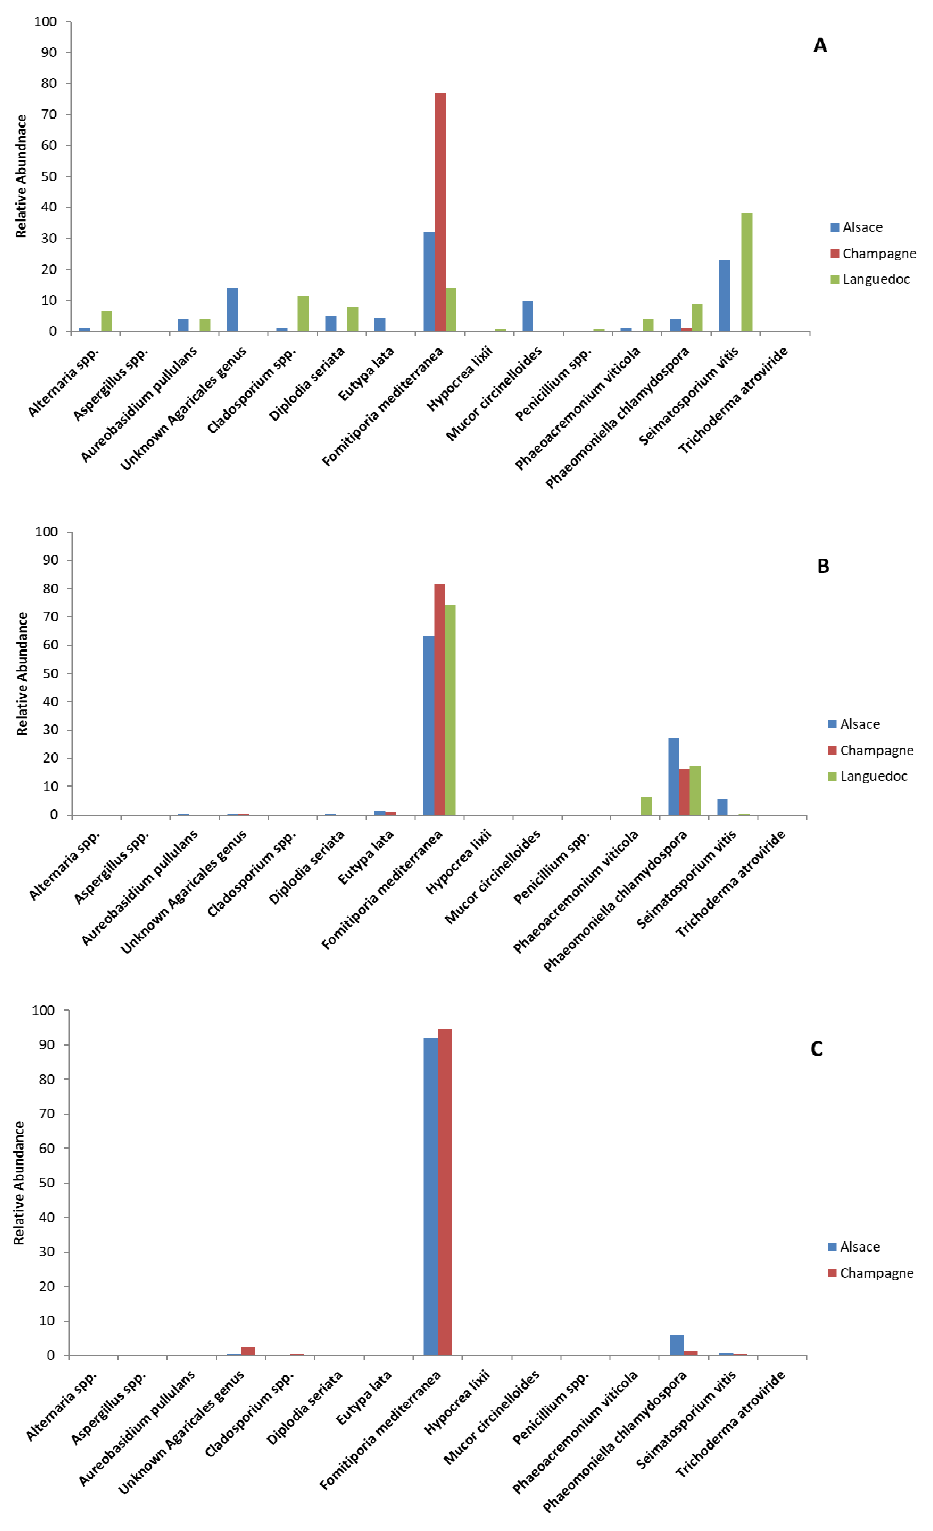
Figure 2. Distribution of fungal taxa in woody tissues of grapevines not treated by sodium arsenite. Data obtained from fungal ITS1 metabarcoding of samples from 2014. %: percentage of OTU reads for a given sample relative to the total number of reads for this OTU. Relative abundance of fungal species in non-necrotic ( A ), border ( B ), and white-rot necrosis ( C ) woody tissues of untreated grapevines from Alsace (blue), Champagne (red) and Languedoc (green).